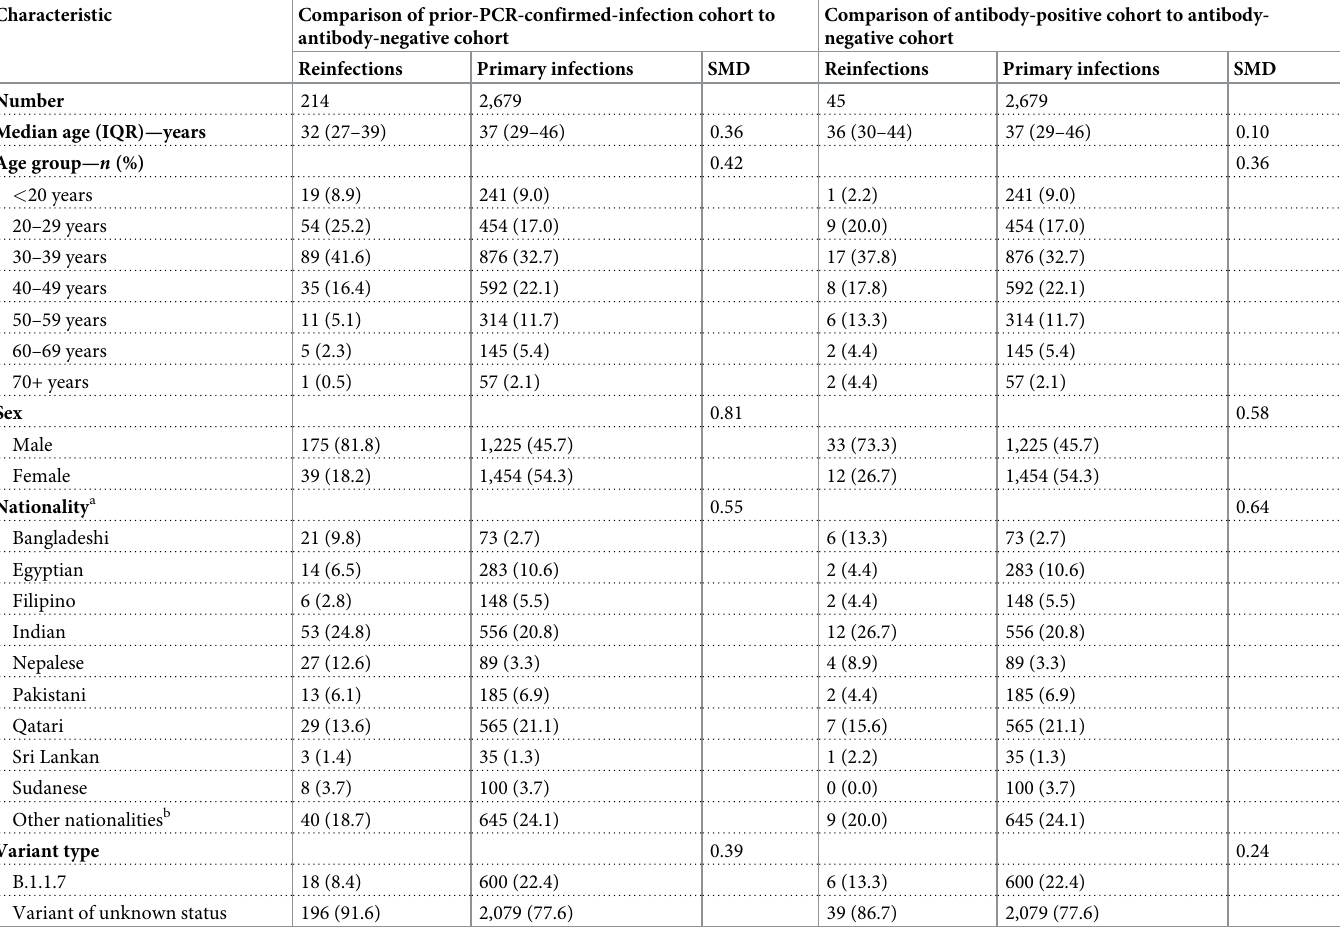
Table 3. Demographic characteristics of individuals with reinfections in the prior-PCR-confirmed-infection and antibody-positive cohorts compared to individuals with primary infections in the antibody-negative cohort. Characteristic Comparison of prior-PCR-confirmed-infection cohort to antibody-negative